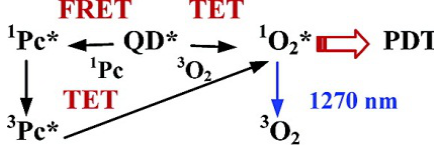
Figure 9. Schematics of the 1 O generation in QD-based PDT systems. Reprinted with 2 permission from [46]. Copyright 2003 American Chemical